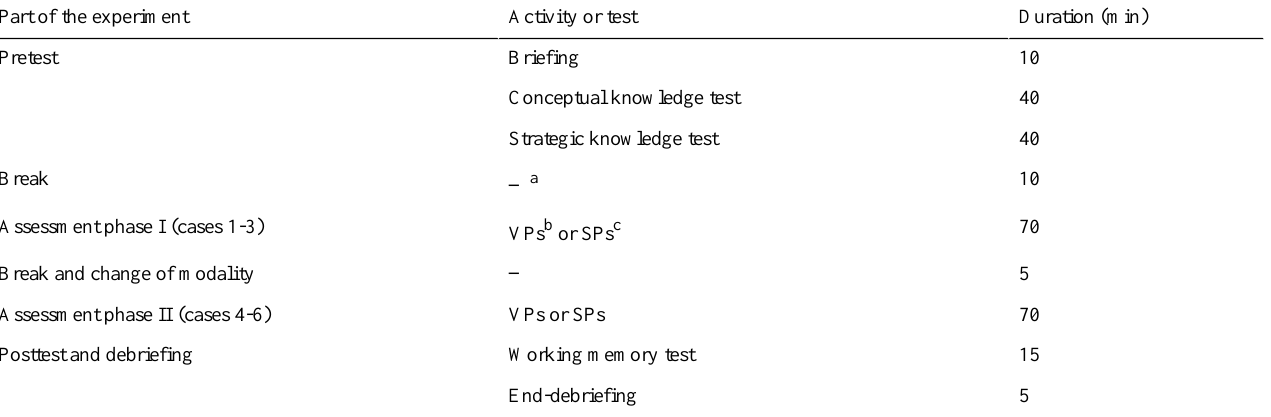
Table 1. General overview of the